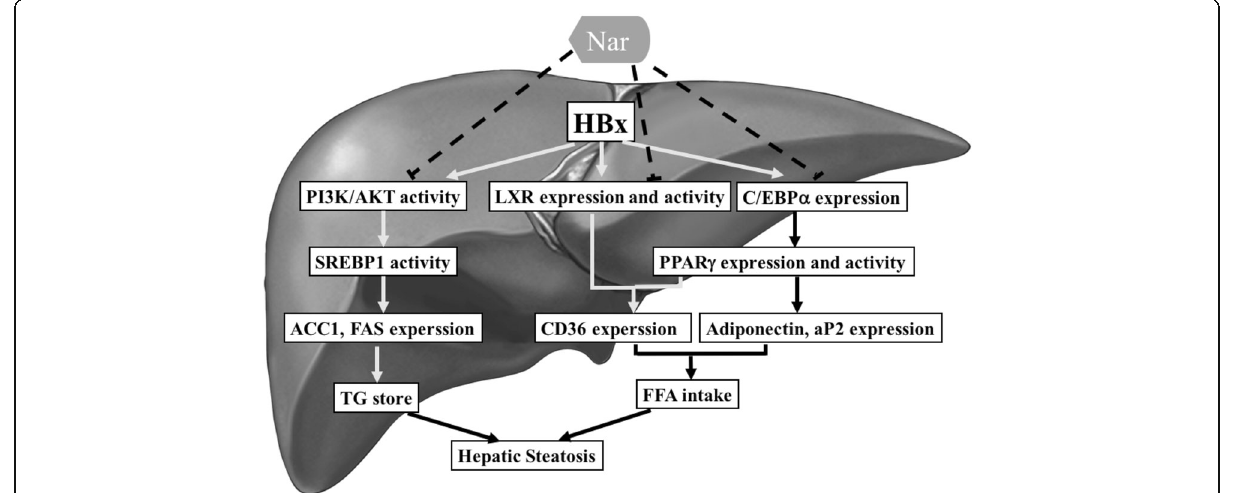
Fig. 6 Schematic diagram illustrates the molecular mechanism of Nar attenuated HBx-induced liver